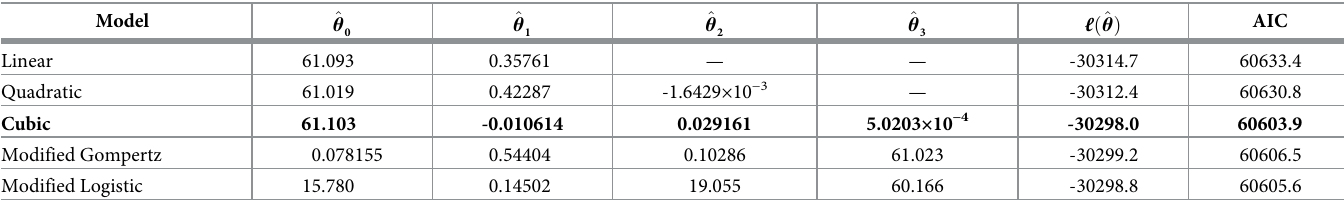
Table 5. Maternal mass models (mass in kg vs. gestational age in